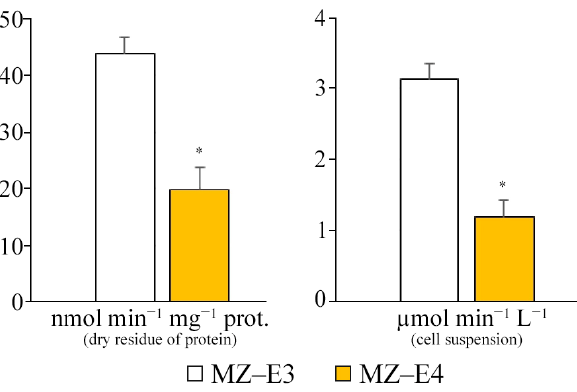
Figure 3. SD activity on the dry residue of protein and cell suspension of Vischeria vischeri strains (MZ–E3; MZ–E4). Medium: BBM; culture volume: 250 mL; incubation time: 25 days; M ± S.E., n = 3; * the differences are significant relative to MZ–E3 ( p ≤ 0.05).